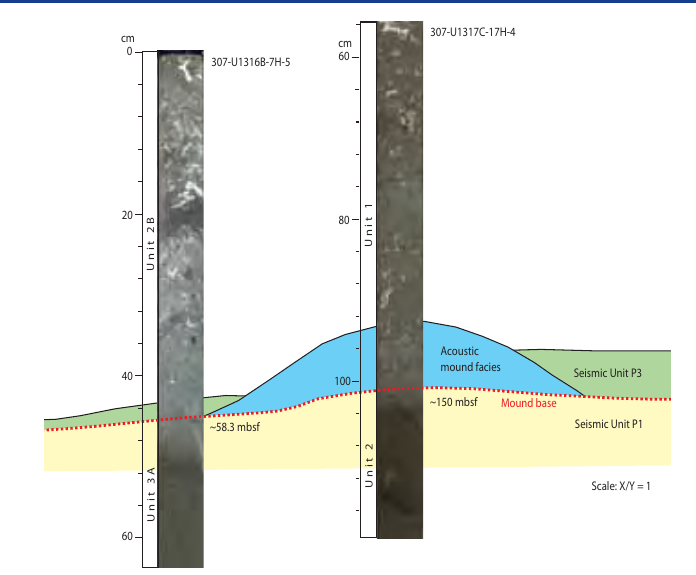
Figure 6. Comparison of mound base core photographs from Sites U1316 and U1317 with schematic representation of the mound.